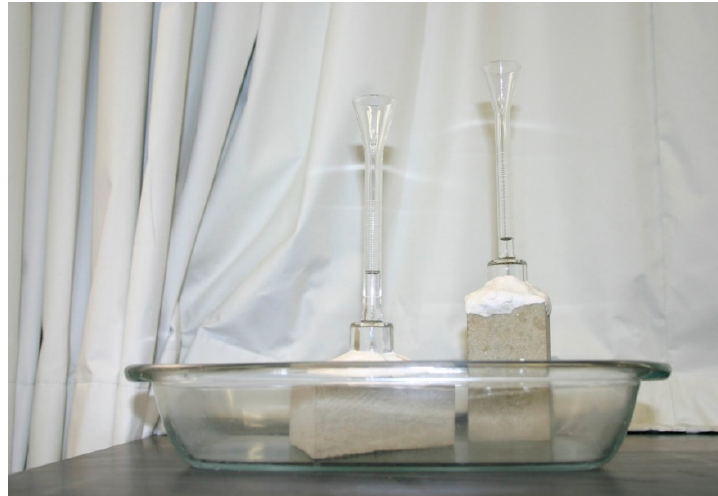
Figure 4. Testing equipment for the absorption of water under low pressure: Karsten glass pipe on sandstone samples inside a glass tray.